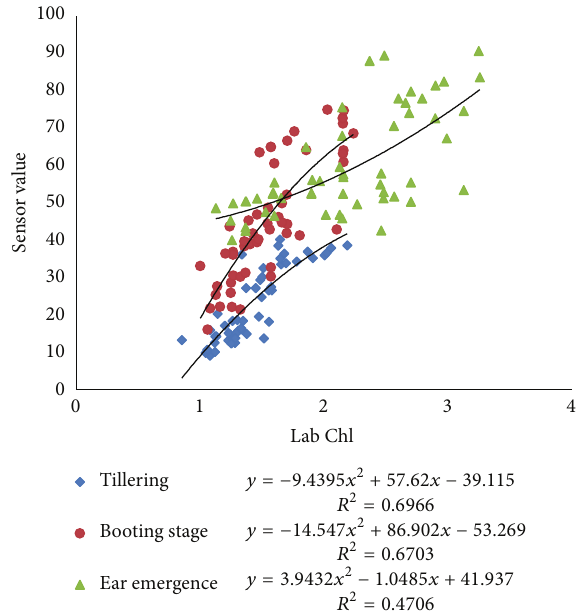
Figure 13: Correlations between sensor values (SN) and Lab Chl at different crop growth stages.